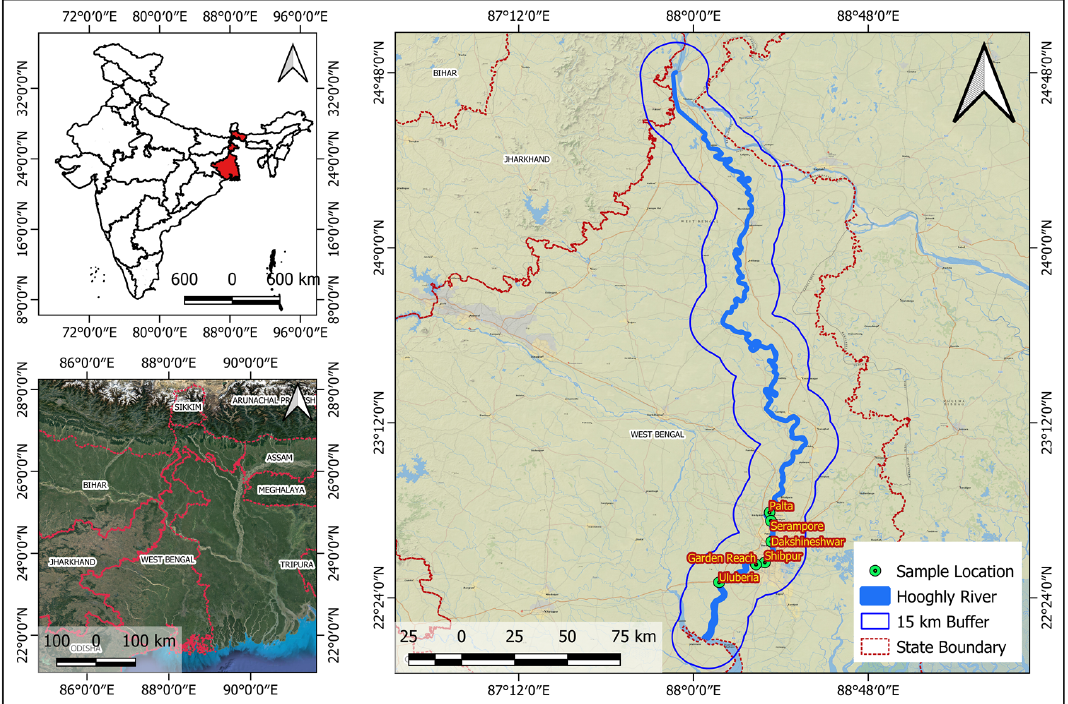
Figure 1. Schematic diagrams of the rivers Ganges and Hooghly with Sampling locations.